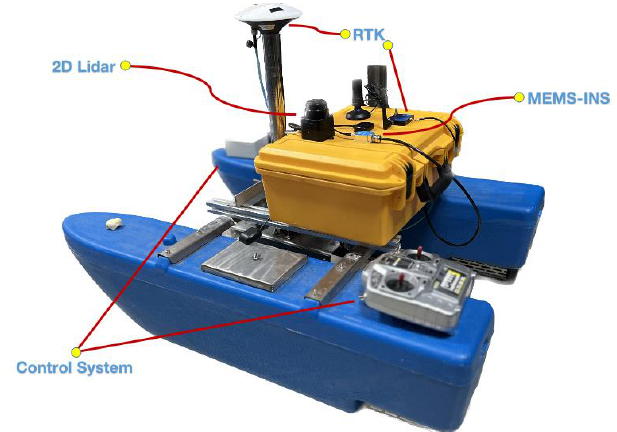
Figure 7. Unmanned craft platform and different sensors.